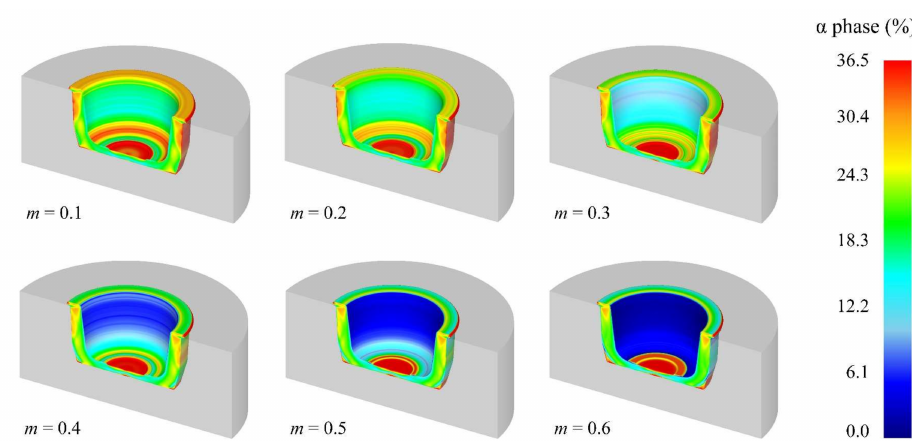
Figure 5. Distributions of α phase under various friction